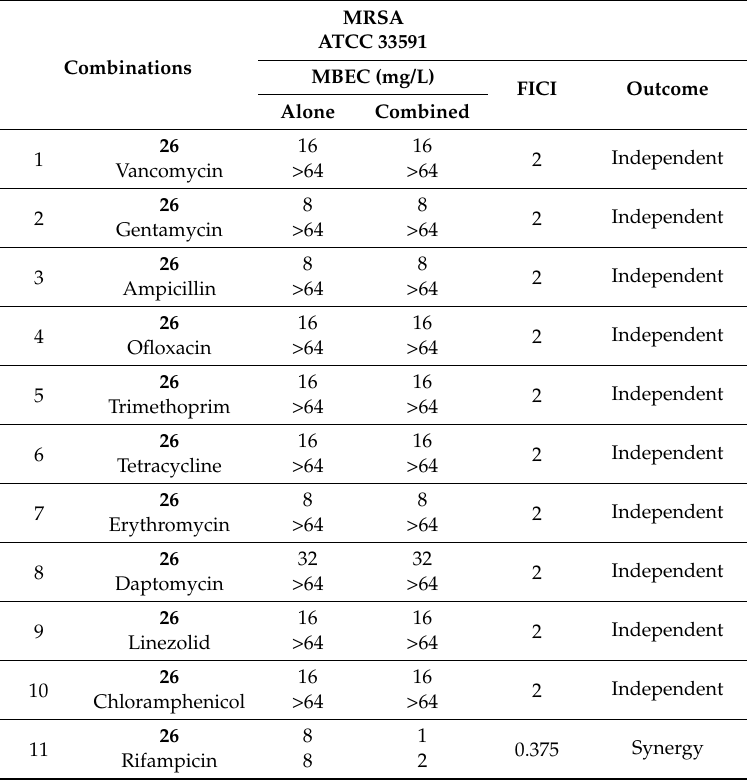
Table 6. Antibacterial activity of 26 in combination with common antibiotics against MRSA in the